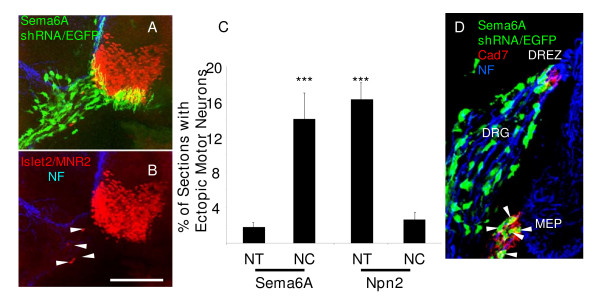
shRNA mediated knockdown of Sema6A in the neural crest, but not in the ventral spinal cord, induces ectopic motorneurons. (a,b) Confocal micrographs of vibratome sections of an HH stage 25 embryo, two days after electroporation in the neural crest with a Sema-6A shRNA-EGFP (green). Embryos were wholemount dual immunostained with antibodies against MNR2 and Islet2 (red) and counterstained with anti-neurofilament (NF, blue). MNR2 and Islet2-positive motor neurons (white arrowheads) can be seen in ectopic positions in the ventral roots but only when accompanied by a large number of Sema-6A shRNA expressing-EGFP-positive (green) neural crest derivatives. Note that EGFP-labelled cells are restricted to neural crest derivatives in the ventral root and that motor neurons, including those in ectopic positions are EGFP-negative. The small amount of EGFP labelling of structures in a ventro-medial position in the spinal cord corresponds to the axon projections of labelled commissural neurons in the dorsal spinal cord. Bar = 100 μm. (c) Quantitative analysis of the prevalence of ectopic motor neurons after electroporation with Sema-6A shRNA-EGFP targeted towards either the ventral neural tube (NT) or dorsal neural tube (neural crest, NC) shows a distinct effect only for neural crest-electroporated embryos. ***P < 0.001; two-tailed t-test. Conversely, knockdown of Npn-2 expression in the neural crest does not induce ectopic motor neurons, unlike knockdown of Npn-2 in the ventral neural tube, as shown earlier (Figure 2). (d) Confocal micrograph of a transverse cryosection (20 μm) immunolabelled with cad7(red) and neurofilament (blue) of an HH23 embryo 2 days after neural crest electroporation of Sema6A shRNA. GFP-positive neural crest cells targeted with Sema-6A shRNA populate the dorsal root ganglion (DRG), the DREZ and the MEP where they express high level of cad7 (red; white arrows), indicating that Sema6A shRNA does not interfere with boundary cap formation.